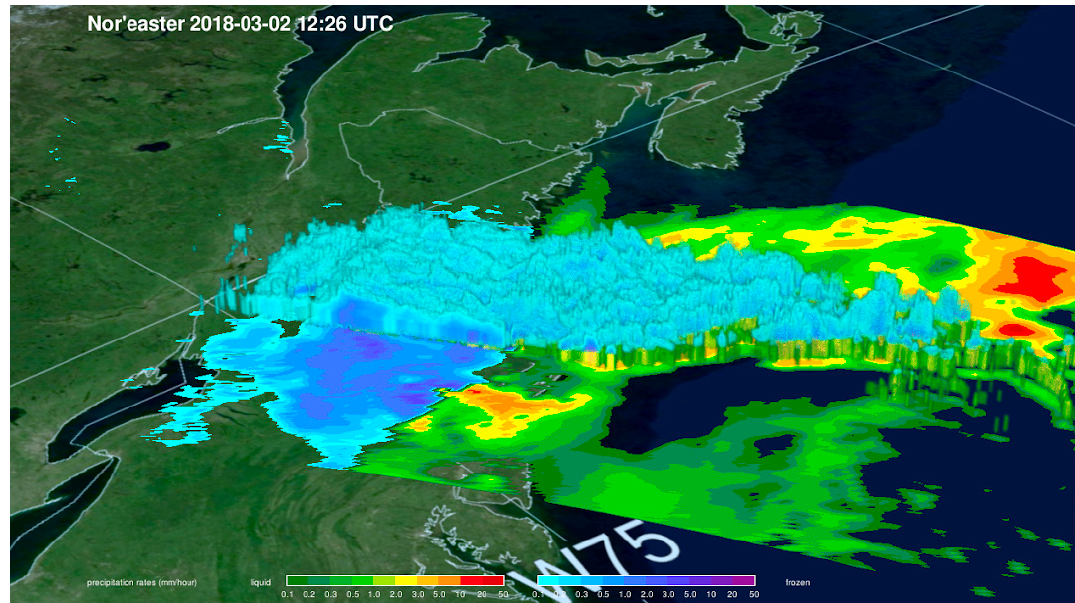
Figure 8. GPM Core Observatory view of the “Nor’easter” winter storm on 2 March, 2018 over the Eastern US. Rainfall rates are shown in warm colors and snow-bearing clouds and falling snow in bluish colors. Courtesy of NASA (https://pmm.nasa.gov/extreme-weather/gpm-examines-snow-destructive-noreaster, last accessed 24 September 2019).